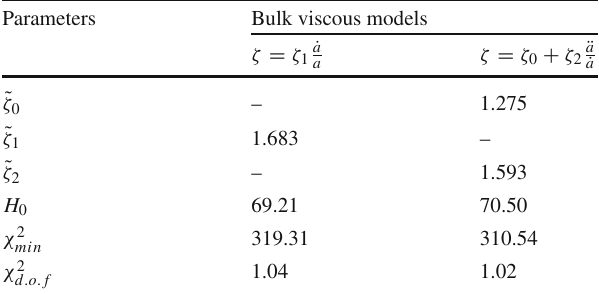
in the model. The subscript d.o.f stands for degrees of freedom. For the best estimation we have use SCP “Union” 307 SNe Ia data sets. The values of parameter corresponding to the first three cases are extracted in